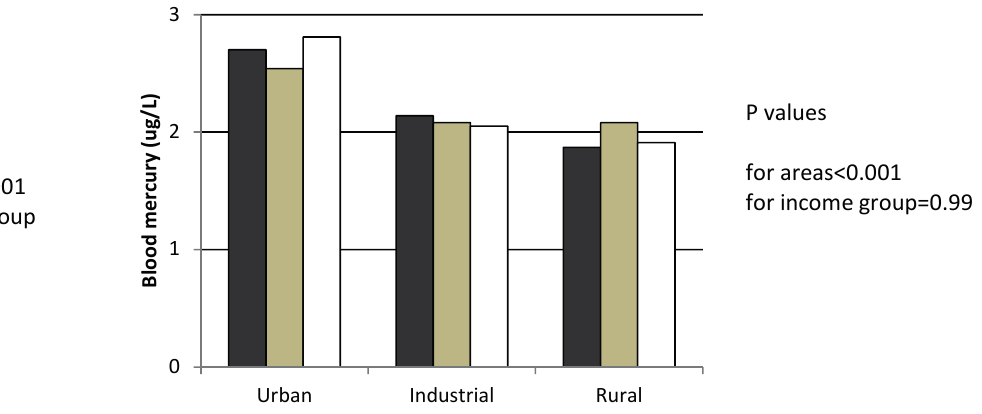
Figure 1. Levels of blood lead and mercury by household income at enrollment and residential areas in the 2281 children, CHEER, Korea, 2005–2006. Geometric mean levels for blood metal were calculated using the multivariate generalized linear model after adjusting for age, gender, child’s weight, second hand smoke, survey year, hour for playing outside (for blood lead), and fish consumption frequency per week (for blood